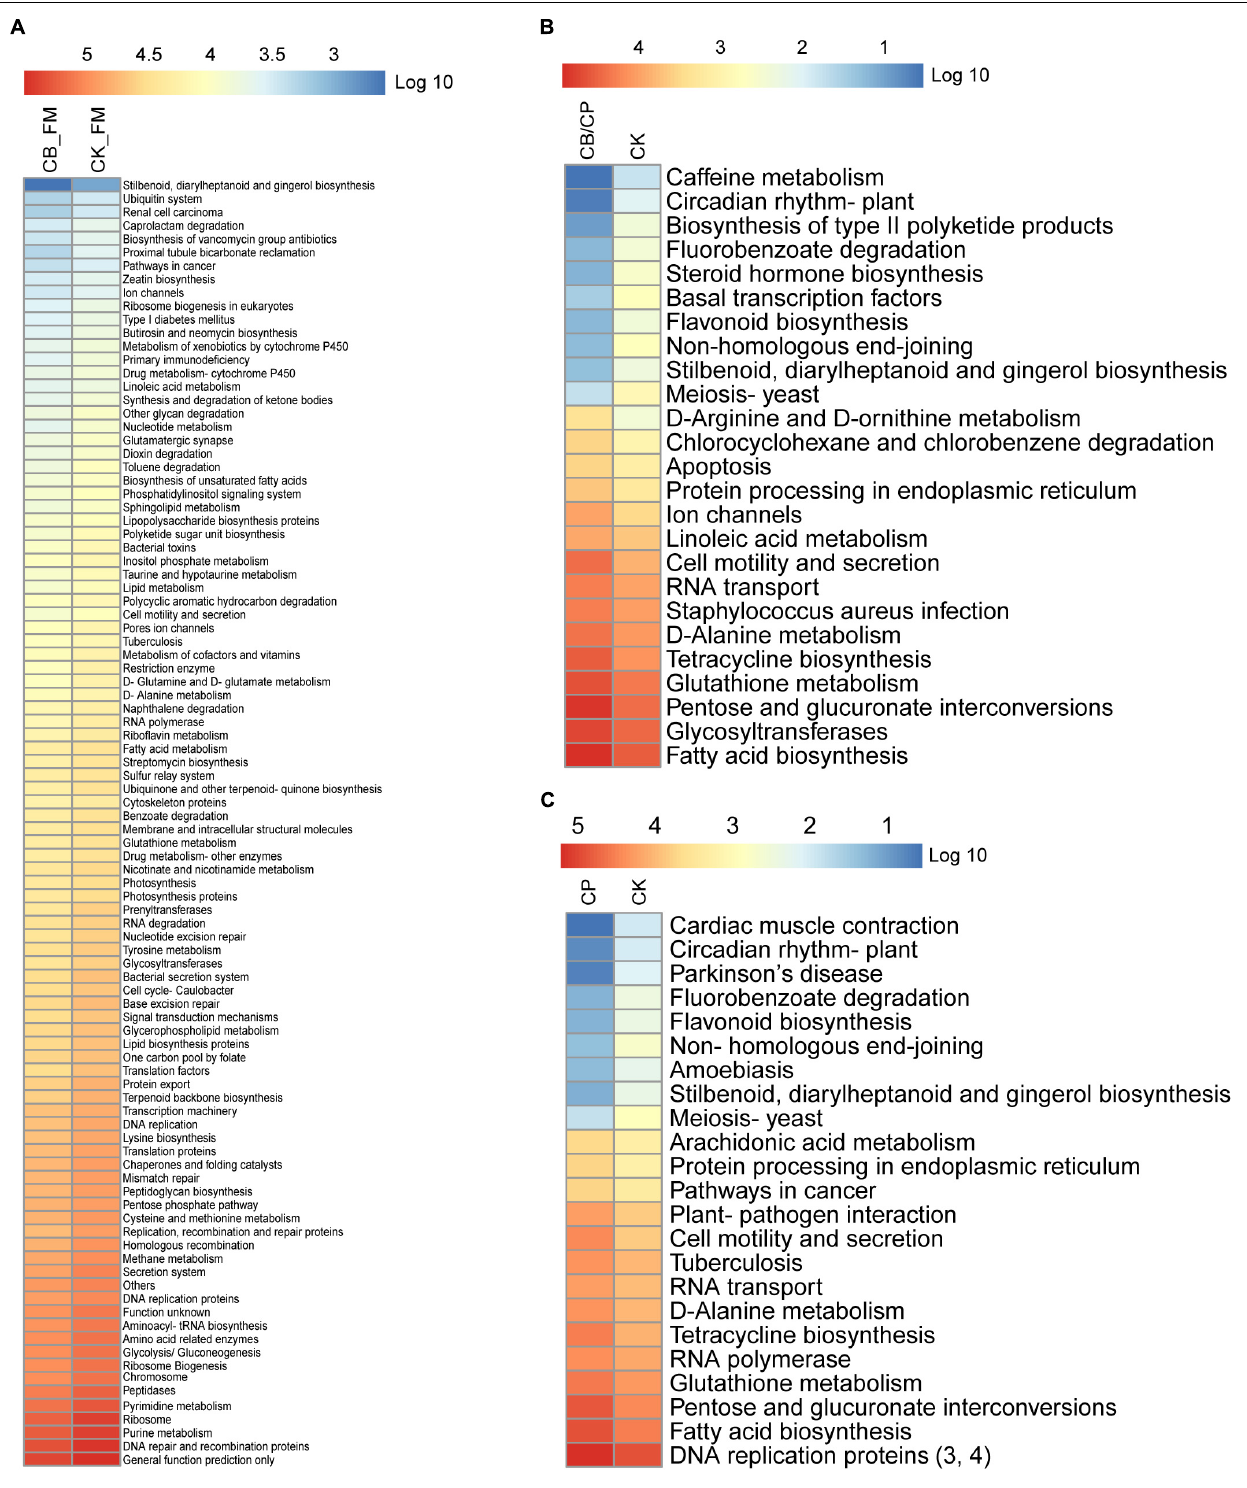
Frontiers in Microbiology |